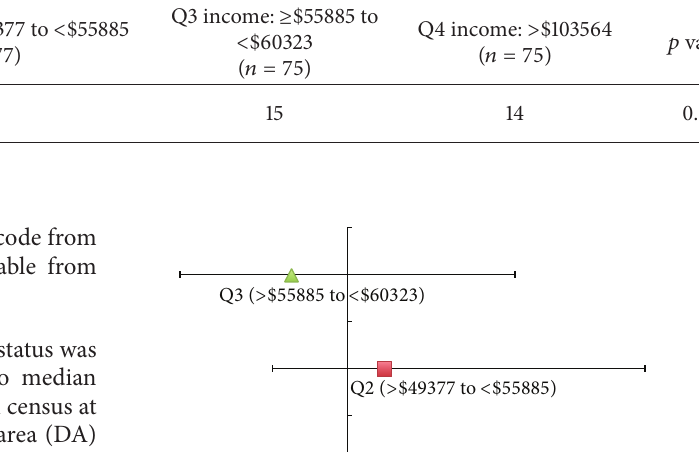
Table 1: Average % of total burns from lowest to highest adjusted median family income.